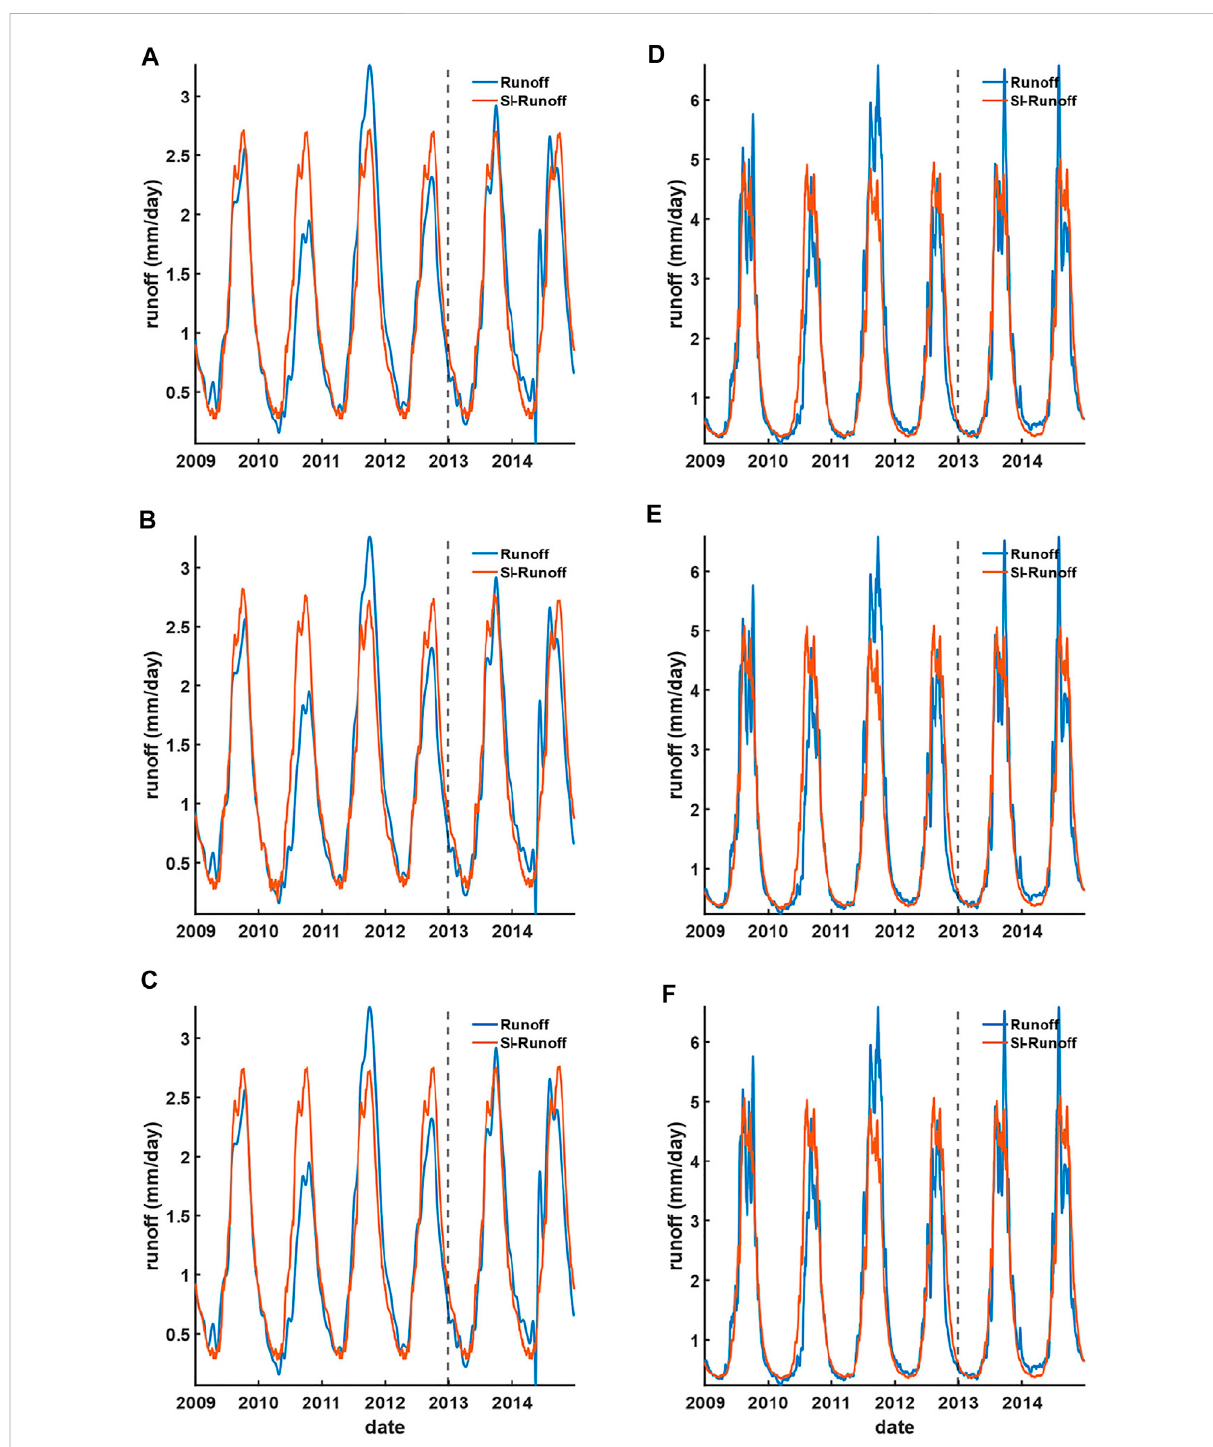
FIGURE 11 Reconstructed(from 2009to 2012) and forecasted (from 2013 to 2014) runoff usingthe upstream GRACE SI against in situ runoff attheTC-CD and Kratie stations based on (A and D) linear regression, (B and E) ANN, and (C and F) LSTM models,